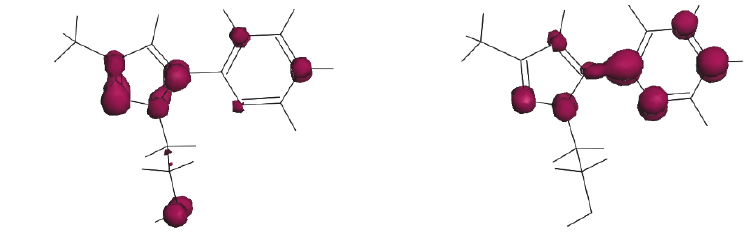
Table 3. Calculated Mulliken and Hirshfeld atomic spin densities (Mulliken atomic spin density is represented at 0.5 level).